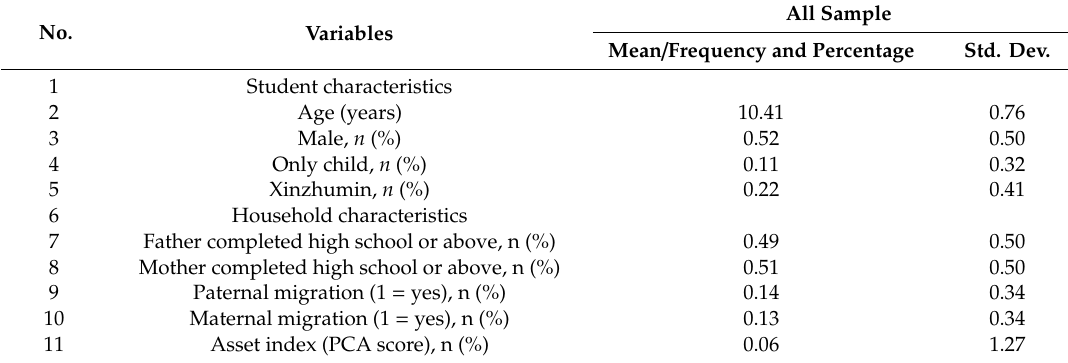
Table 1. Descriptive statistics of student and household characteristics, n = 1655.